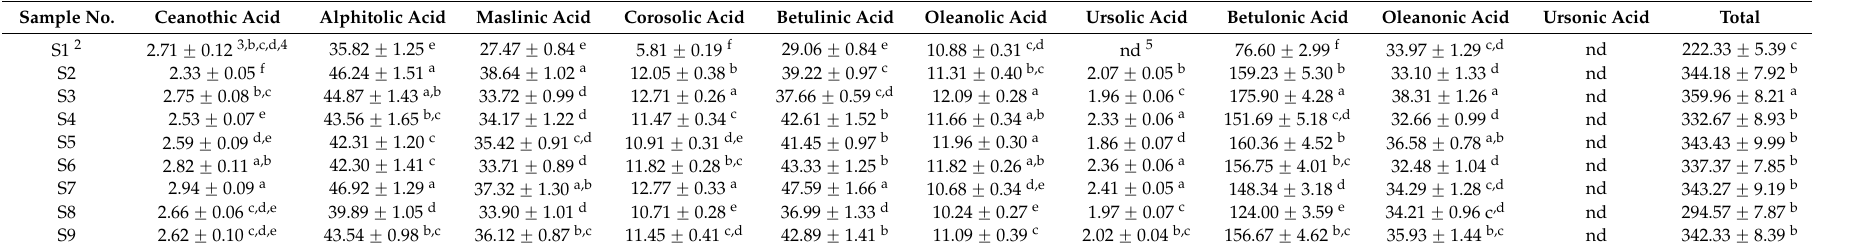
Table 2. The analysis results of triterpenic acids in the samples (mg/100 g, DW 1 , n = 3). Sample